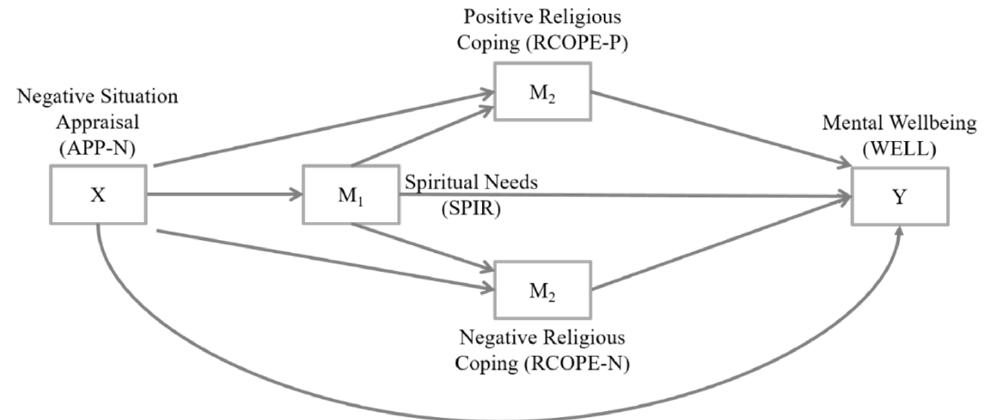
Figure 1. Conceptual form of the expected mediation model.